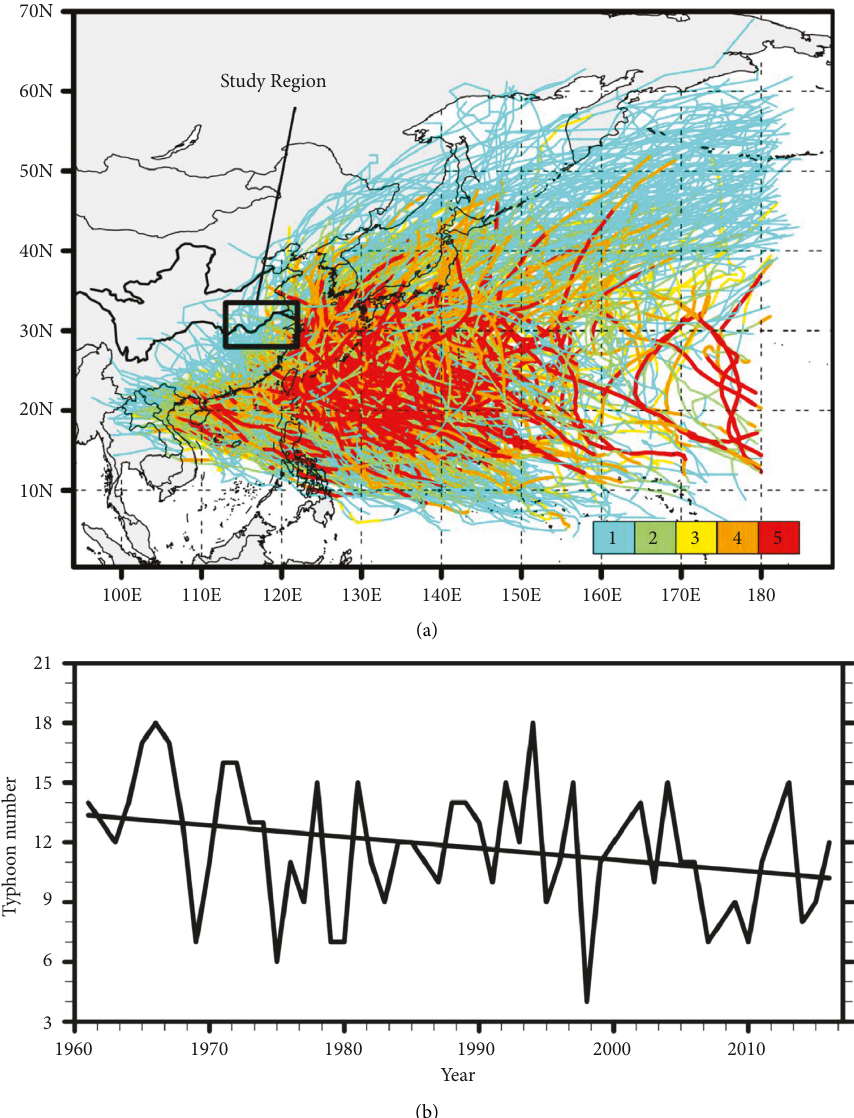
Figure 2: (a) All the typhoon tracks and (b) the time series of the number of typhoons during the summers of 1961–2016. Note. The straight line of the time series presents a linear trend. The same is true as